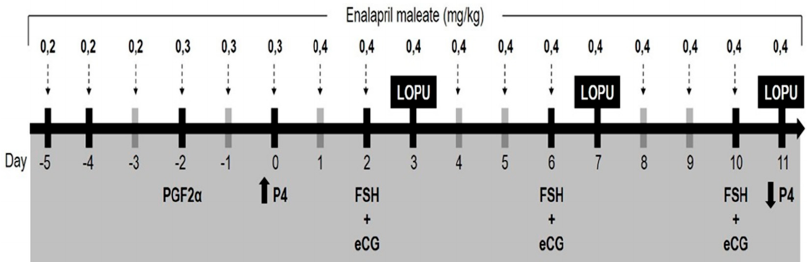
Figure 1. Timeline of enalapril maleate administration, estrus synchronization, and ovarian stimulation in goats oocyte donors by serial laparoscopic ovum pick-up (LOPU) (protocols adapted from Gibbons et al.